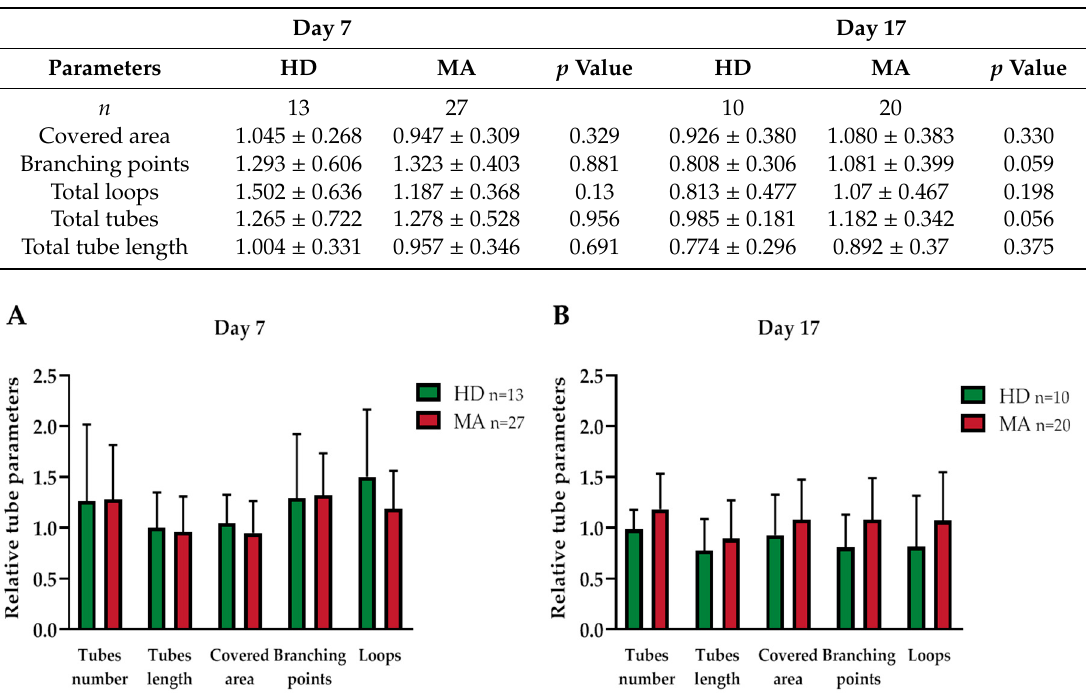
Table 2. Normalized values for % of covered area, number of branching points, total number of loops, total tube number, and total tube lengths in the tube formation assay, performed with conditioned media collected at days 7 and 17 after seeding of EPCs of HD and of a heterogeneous group of MA patients: Data were expressed as mean ± SD, and statistical significance was calculated through Student’s t -test. Values of at least three independent experiments are shown.